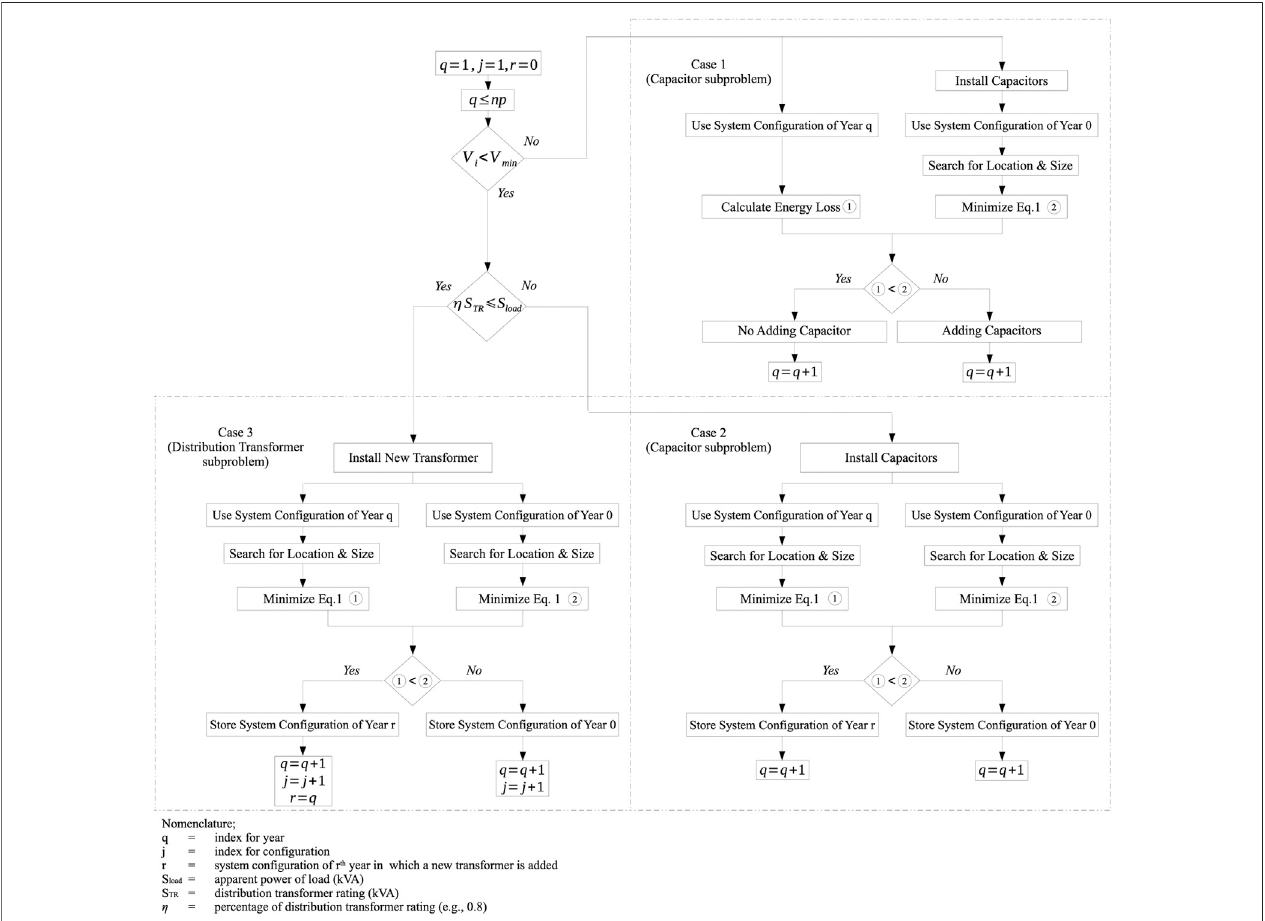
FIGURE 4 | Proposed optimization procedure for capacitor and distribution transformer